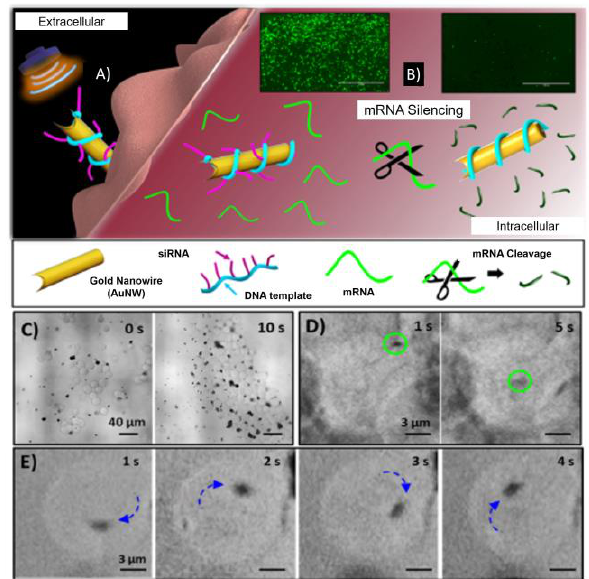
Figure 5. ( A ) . Schematic representation of GFP / RCA-AuNW penetration in HEK293-GFP cell due to the nanomotor movement stimulated by ultrasound (US)-powered propulsion, and ( B ) gene-mRNA silencing in living cells. ( C ) Time-lapse images illustrating the penetration of a GFP / RCA-AuNW (black dots) into a HEK293-GFP cell (light spheres) at 10 s intervals, ( D ) 4 s intervals and ( E ) 1 s intervals. The blue arrows indicate the direction of the motion. Reproduced with permission from [179], Copyright American Chemical Society, 2016.